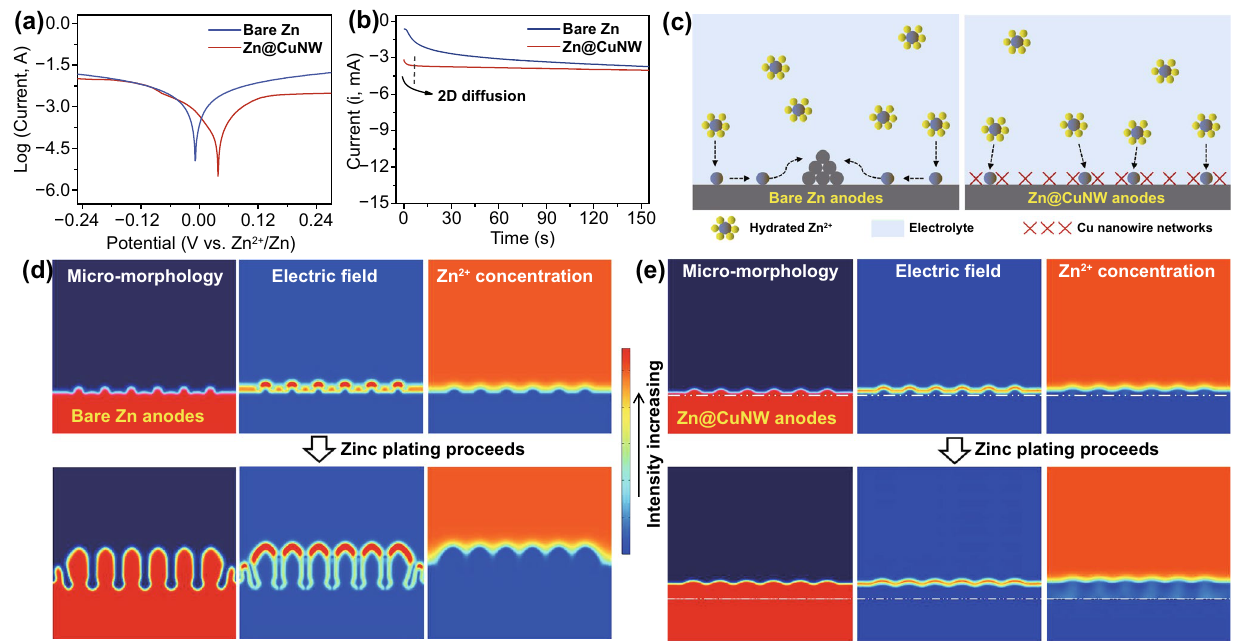
Fig. 3 a Linear polarization curves and b chronoamperometry curves of the bare Zn anodes and Zn@CuNW anodes. c Schematic illustration of rampant 2D diffusion behaviors on the bare Zn anodes (left) and restrained 2D diffusion on the Zn@CuNW anodes. Simulation of surface micro-morphology, electric field and Zn 2+ concentration field during the zinc plating process on d bare Zn anodes and e Zn@CuNW anodes (the white dash dot lines point out the original position of Cu nanowire networks/zinc anode